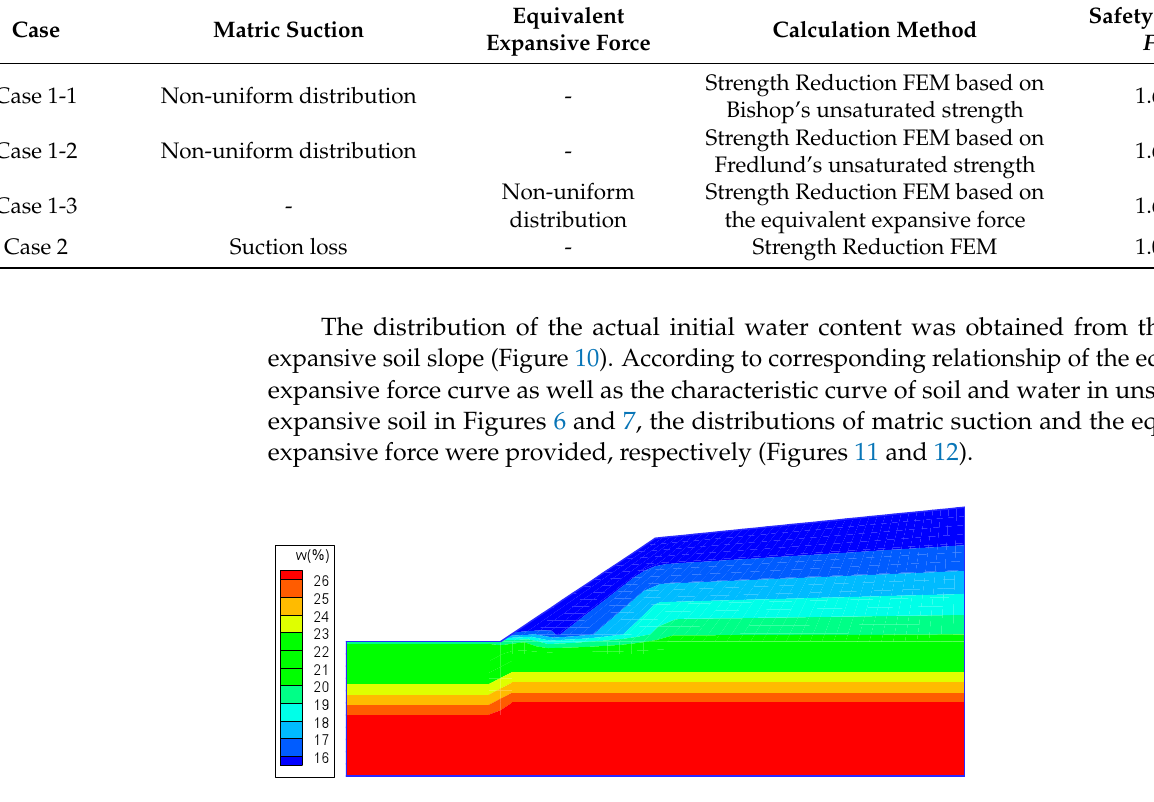
Figure 10. Contours of the water content (unit: %).